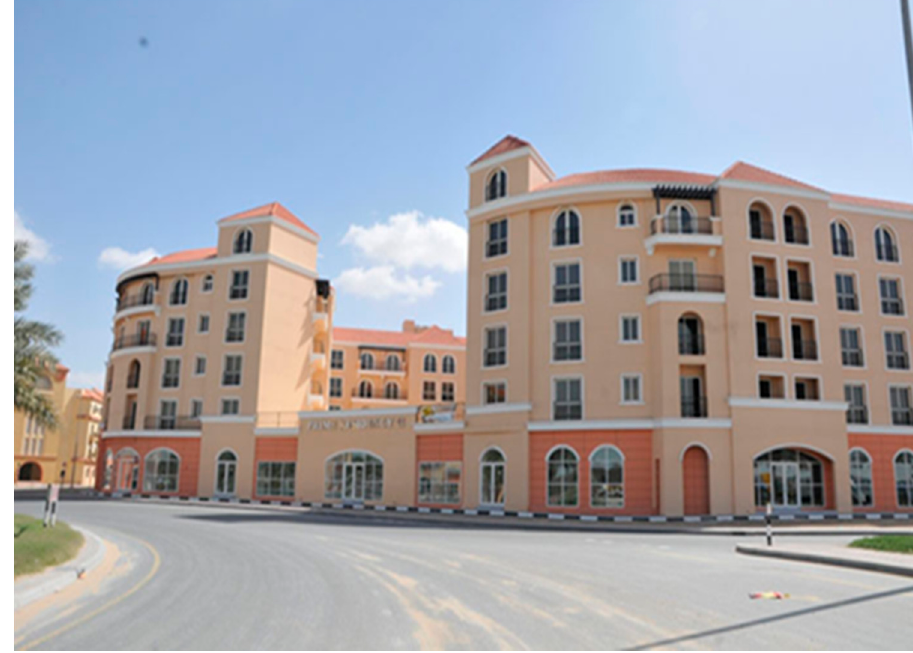
Figure 3. Prime Residency II (PR II), International City, Dubai, UAE.